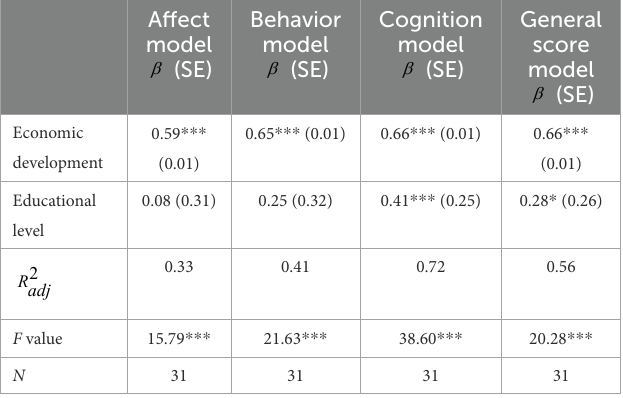
TABLE 4 Multiple regression models predict Weibo users’ attitudes at the provincial